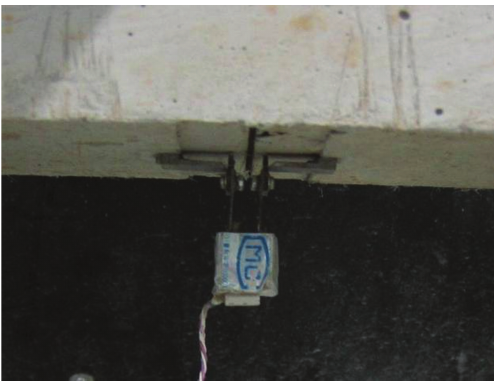
Figure 6: P-CMOD for concrete with 1kg long